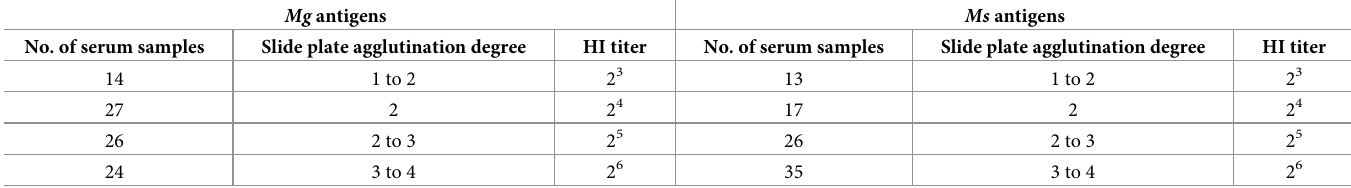
Table 2. Hemagglutination inhibition (HI) titers as compared with the slide plate agglutination titers in chicken serum samples against Mg and Ms antigens. Mg antigens Ms antigens No. of serum